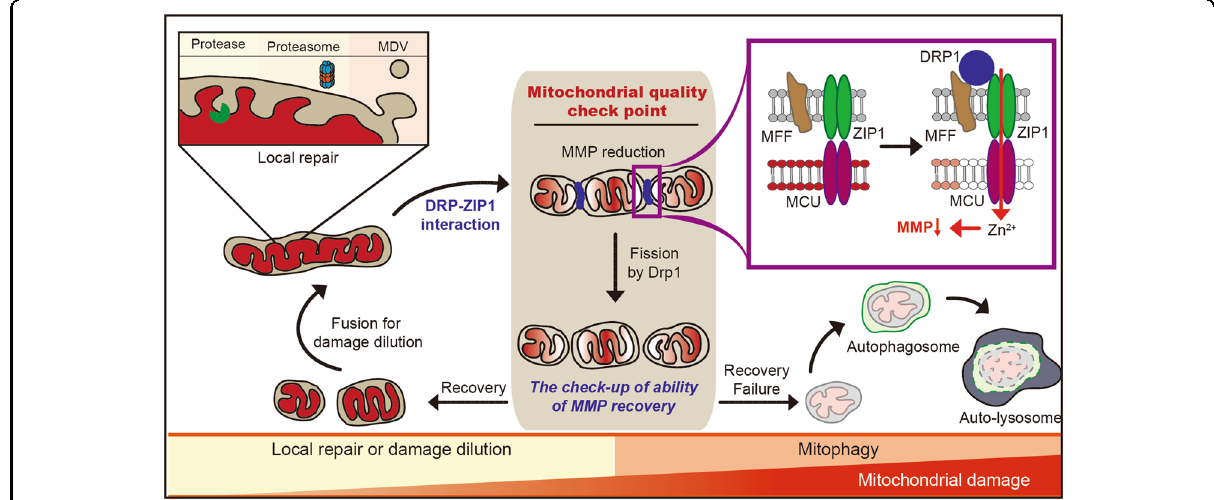
Fig. 2 Mitochondrial quality control systems in cells. Mitochondrial proteases or proteasomes can remove damaged proteins from the mitochondria. In some cases, a small portion of a mitochondrion containing damaged proteins is segregated as a vesicle (MDV) and transferred to the lysosome. Massive mitochondrial damage that induces a reduction in mitochondrial membrane potential (MMP) triggers mitophagy. Under physiological conditions, the mitochondrial fi ssion protein DRP1 focally reduces the MMP at the mitochondrial fi ssion site via interactions with the mitochondrial zinc transporter ZIP1. This DRP1-induced MMP reduction serves to discriminate and selectively remove only damaged mitochondrial fragments through the localized induction of the mitophagy